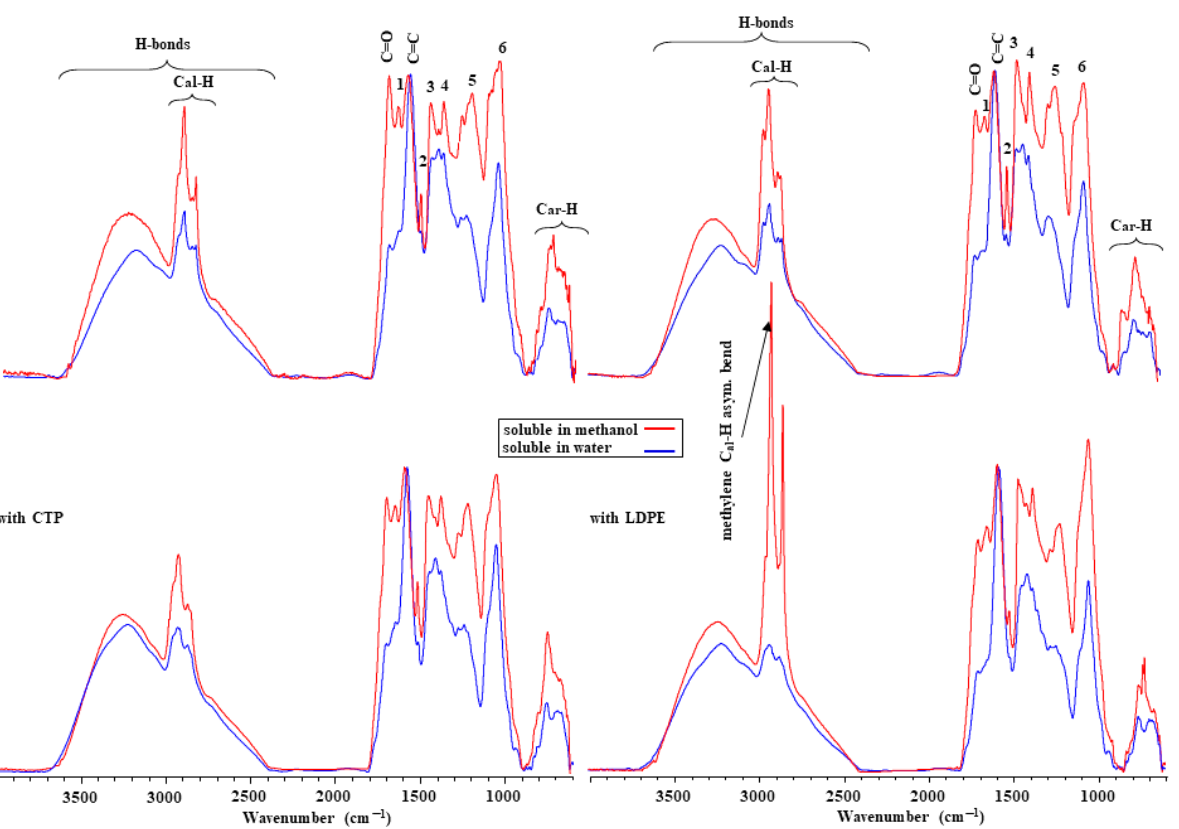
Figure 5. The ATR spectra of condensed material. (1) vibrations of esters, ketones, and aldehydes; (2) aromatic skeletal vibrations in fragments with guaiacyl rings; (3) C–H asym. deformation of –